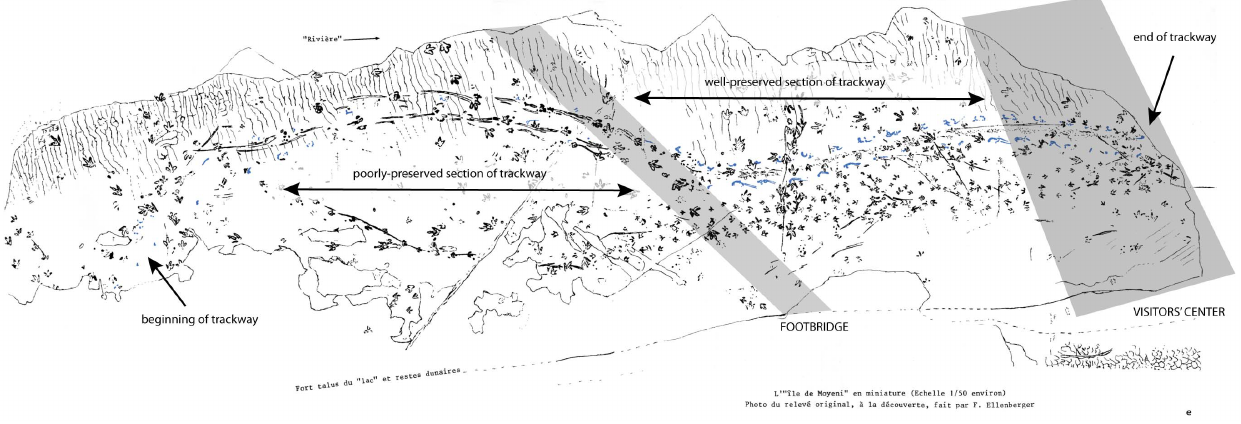
Figure 2. Moyeni tracksite. Track surface exposed during 1960s and 1970s, with original interpretations of tracks and surface morphology by Ellenberger ([3]; foldout e). Current position of footbridge and Visitor Center are shown schematically by translucent gray polygons. The trackway of Episcopopus ventrosus is highlighted in blue, and the first and last recorded steps are indicated.